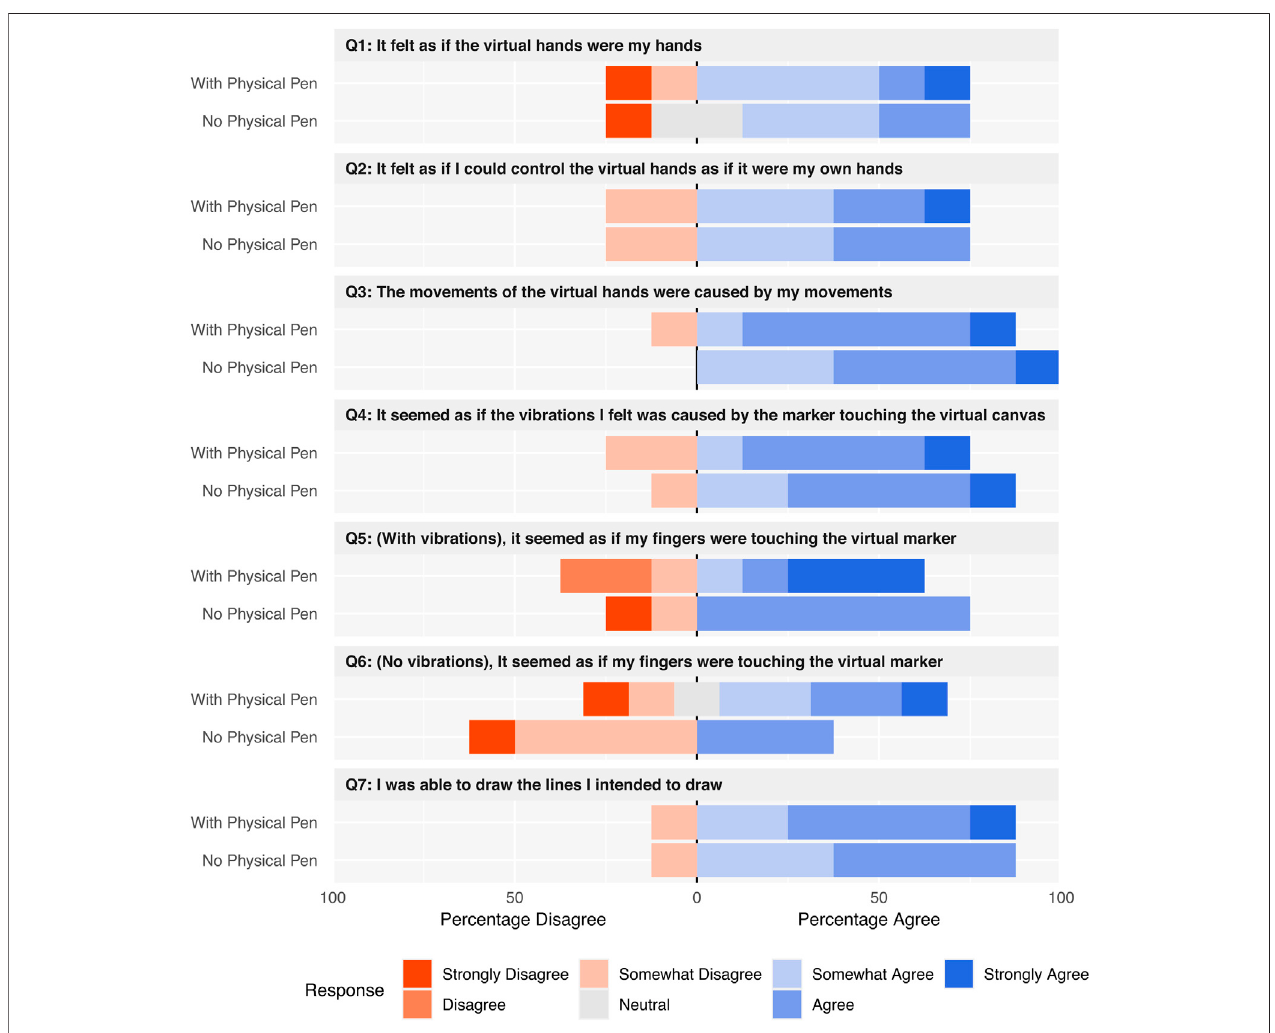
FIGURE 10 | Results from the questionnaire provided during the end of each set of